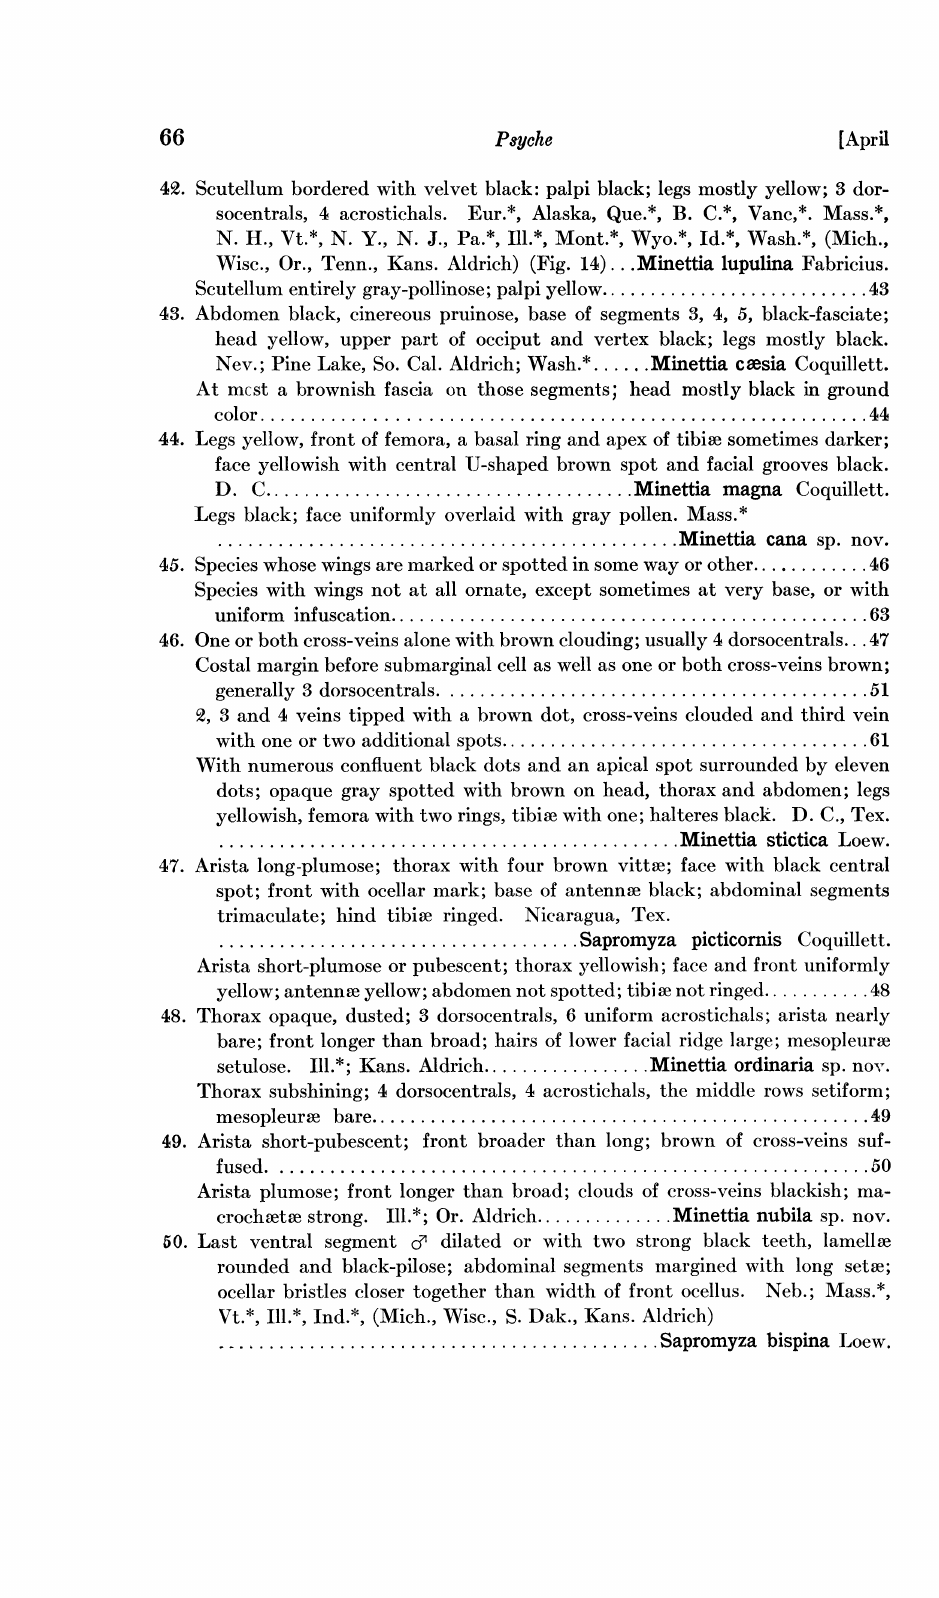
Legs black; face uniformly overlaid with gray pollen. Mass.*